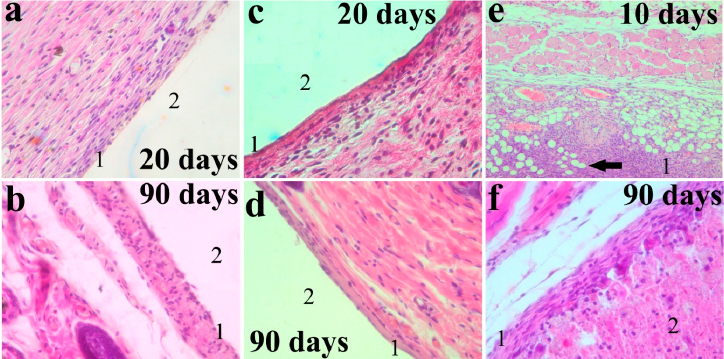
Figure 5. Micrographs of the implantation zone of the PCL ( a , b ), 75 / 25 composite ( c , d ), and metallic glass sample ( e , f ). ( a ) The smooth line of connective tissue (1) between the implantation zone (2) and tissues of the organism; no signs of inflammation and destruction of the tissues; hematoxylin and eosin staining; and magnification of 400 × . ( b ) The smooth line of connective tissue (1) between the zone of implantation (2) and tissues of the organism; no signs of inflammation and destruction of the tissues; hematoxylin and eosin staining; and magnification of 400 × . ( c ) The smooth line of connective tissue (1) between the implantation zone (2) and tissues of the organism; no signs of inflammation and destruction of the tissues; hematoxylin and eosin staining; and magnification of 400 × . ( d ) The smooth line of connective tissue (1) between the implantation zone (2) and tissues of the organism; no signs of inflammation and destruction of the tissues; hematoxylin and eosin staining; and magnification of 400 × . ( e ) Inflammation, neutrophil, and macrophages cell infiltration in the implantation zone and gas bubbles (marked by an arrow); the sample underwent bio-destruction; hematoxylin and eosin staining; and magnification of 100 × . ( f ) Inflammation, connective tissue (1) surrounds the implantation zone filled with macrophages and cell detritus (2); the sample underwent bio-destruction; hematoxylin and eosin staining; and magnification of 400 ×